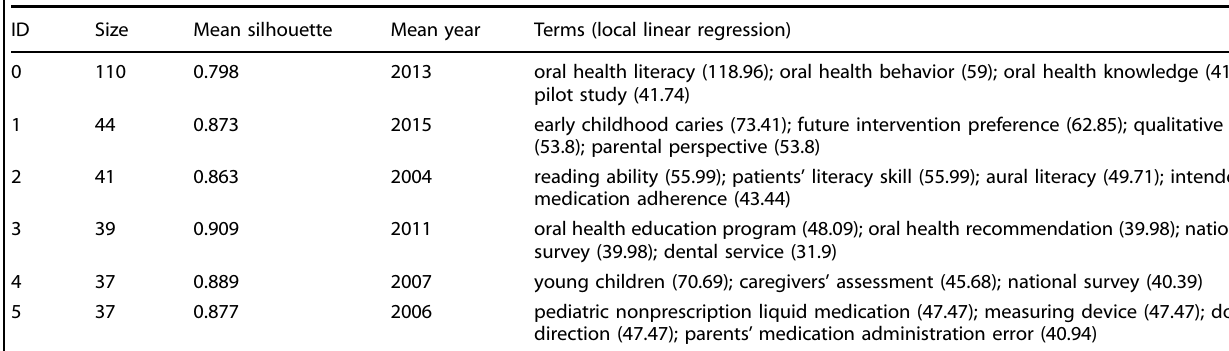
Table 6. Major reference co-citation